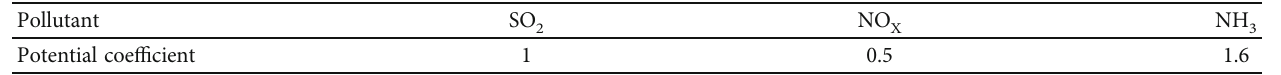
Table 25: AP pollutants and potential coe ffi cients.